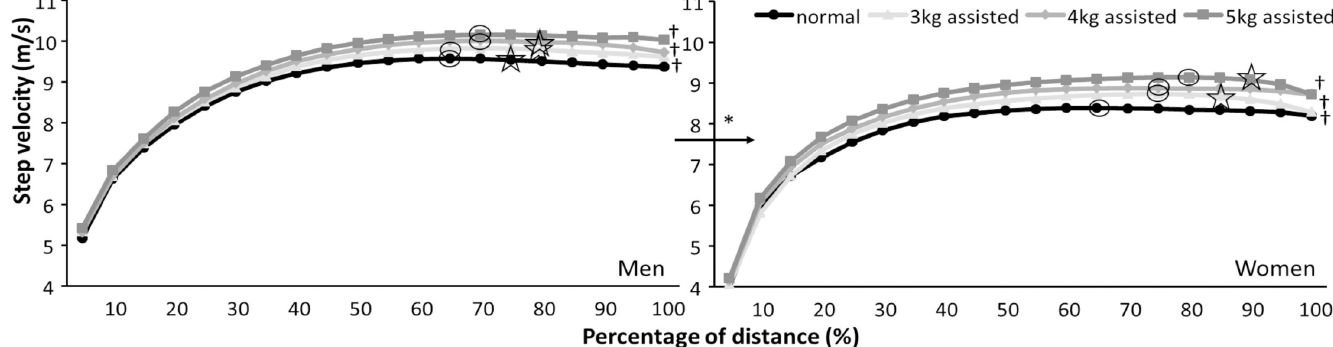
Fig 3. Average velocity per 5% of the distance during normal and 3, 4, and 5 kg assisted 60 m sprints for men and women. � indicates a significant difference between men and women for each of the sprint conditions. ʘ indicates where maximal velocity was reached for this condition. indicates where values decreased again for this condition.